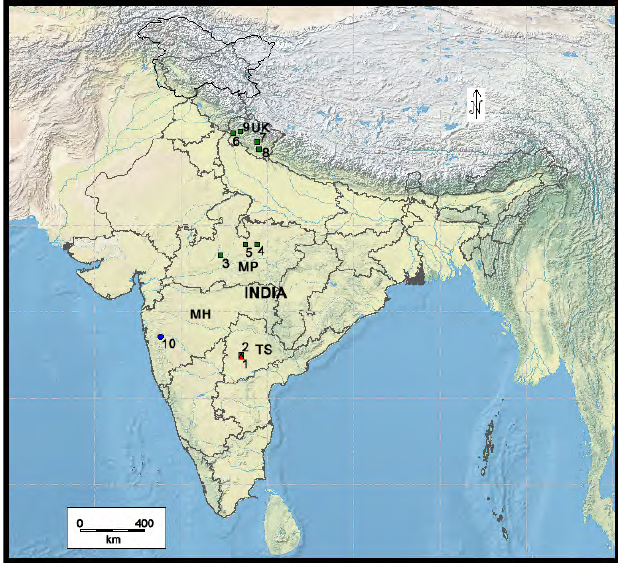
Lymnaea biacuminata Figure 1. Distribution map of in India. 1, Hyderabad; 2, Secunderabad; 3, Bhopal; 4, Damoh; 5, Sagar; 6, Dehradun; 7, Kumaon; 8, Nainital; 9, Tehri; 10, Pune (new record); MH, Maharashtra; MP, Madhya Pradesh; TS, Telangana; UK,